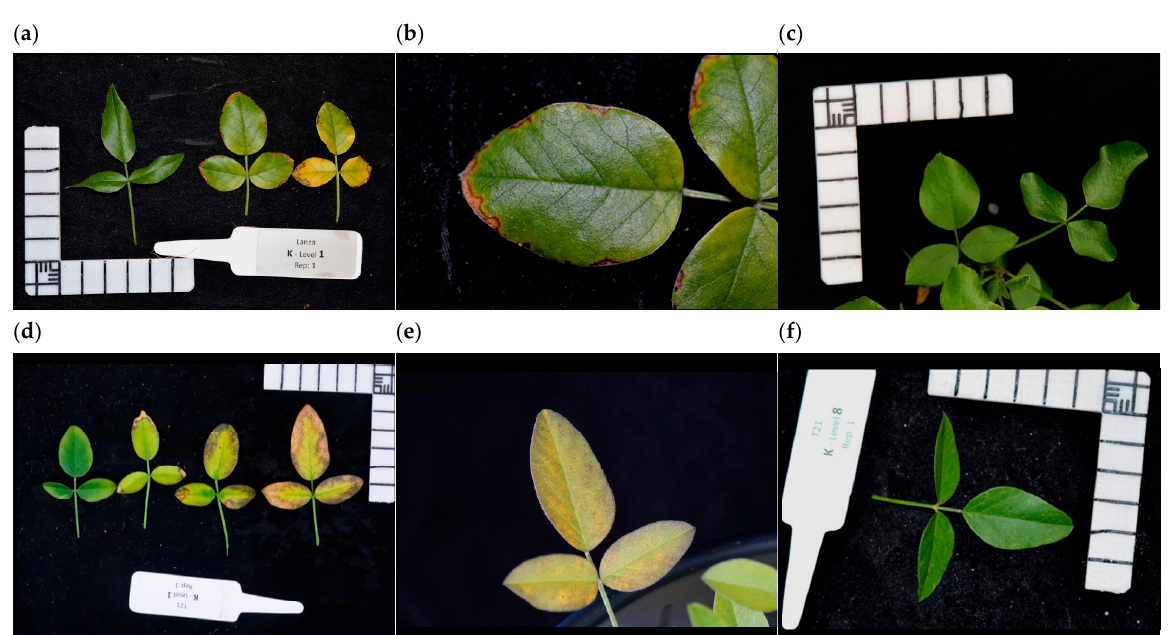
Figure 8. Images of leaves taken from Lanza ® tedera ( a – c ) and Palma ( d – f ) grown in soils with deficient levels of potassium ( a , b , d , e ) and adequate potassium ( c , f ). Symptom progression from younger to older leaves (L to R) is shown in panels ( a , d ). Tedera leaves displayed marginal necrosis in response to high levels of K (~150 mg kg − 1 Colwell K). However, in contrast to K deficiency, K toxicity symptoms included a distinct ring of chlorosis around the necrotic margins (Figure 9b,d), and the widespread spotting seen in tedera T21 due to K deficiency was not seen under toxicity conditions. Symptoms of K toxicity were more pronounced in older leaves (Figure 9a,c), likely due to the accumulation of toxic K levels over time, and leaves dropped readily once badly affected.